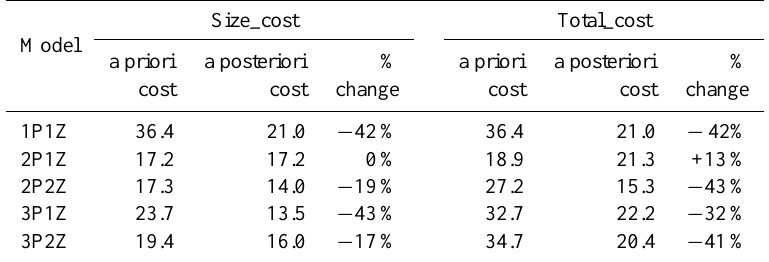
Table 4. Cost functions (Size_cost and Total_cost) computed at the five independent CV sites in experiment 2, using initial parameter values (i.e., a priori cost) and optimal parameter values obtained from the assimilation of satellite-derived size-fractionated chlorophyll and POC data at the four DA sites (i.e., a posteriori